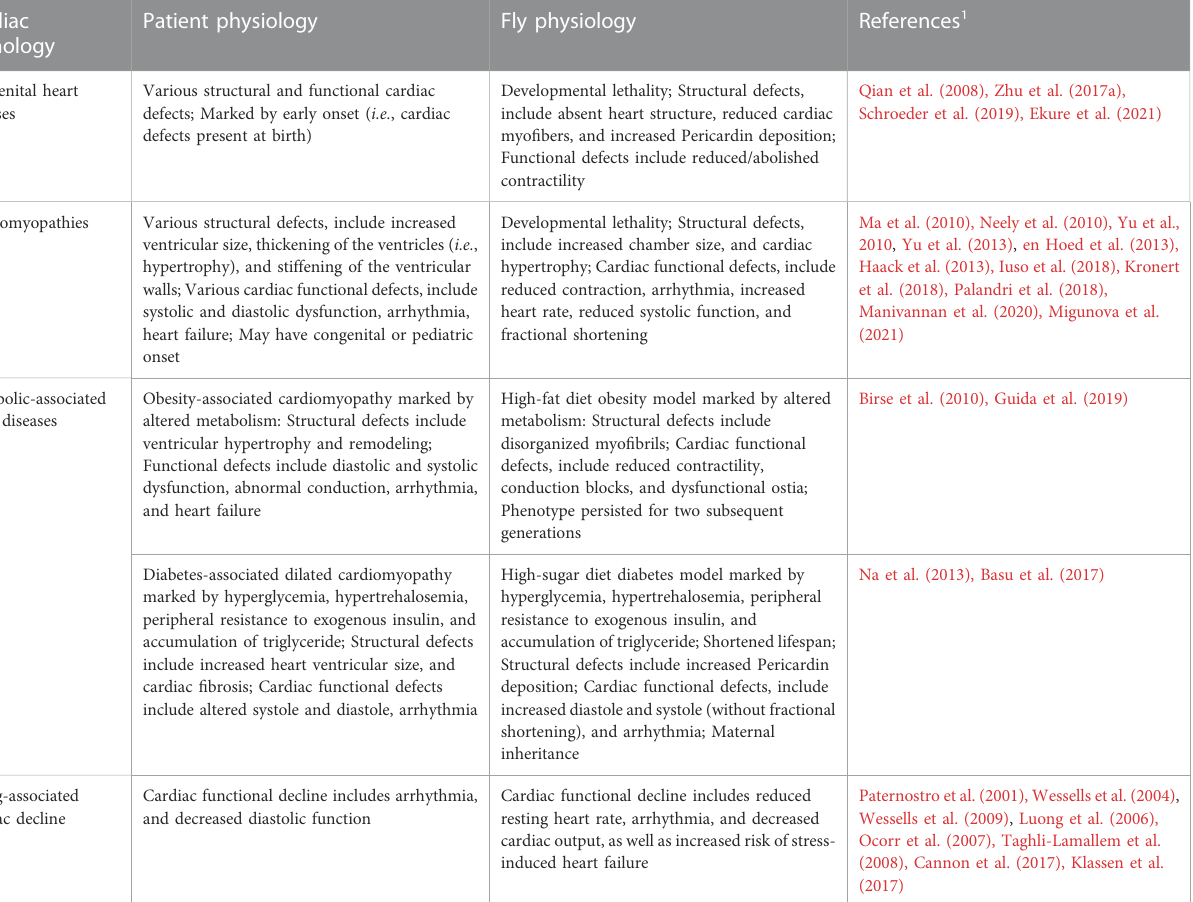
TABLE 1 Drosophila models of human cardiac